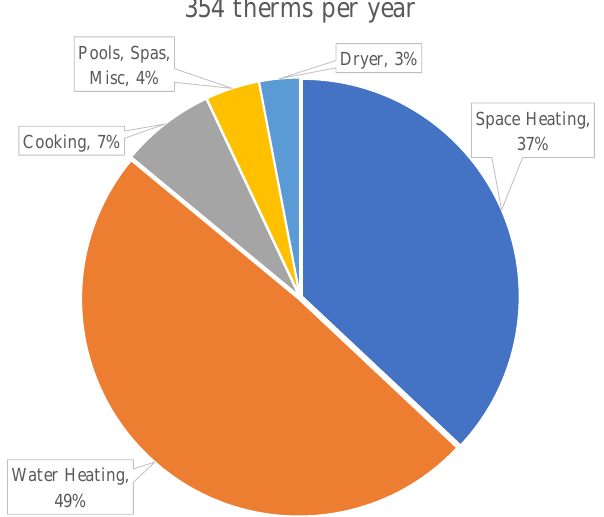
Figure 2. Breakdown of residential natural gas use in California in 2009 [20].